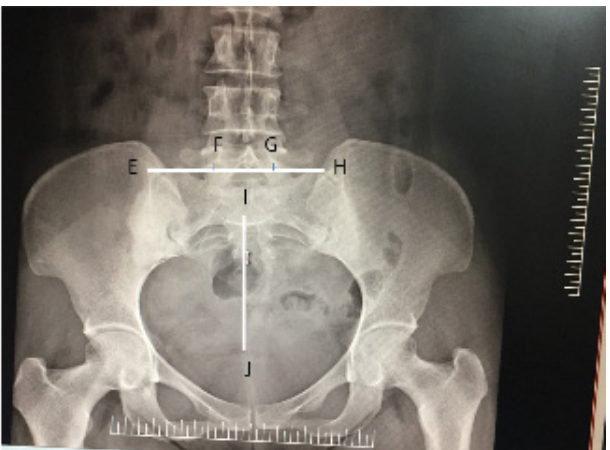
Figure 1. Measurement of sacral parameters (I to J: Sacral length, E to H: Sacral breadth, F to G: Transverse diameter of S1, E to F: Right alar length and G to H: Left alar length) For sex determination, following indices were